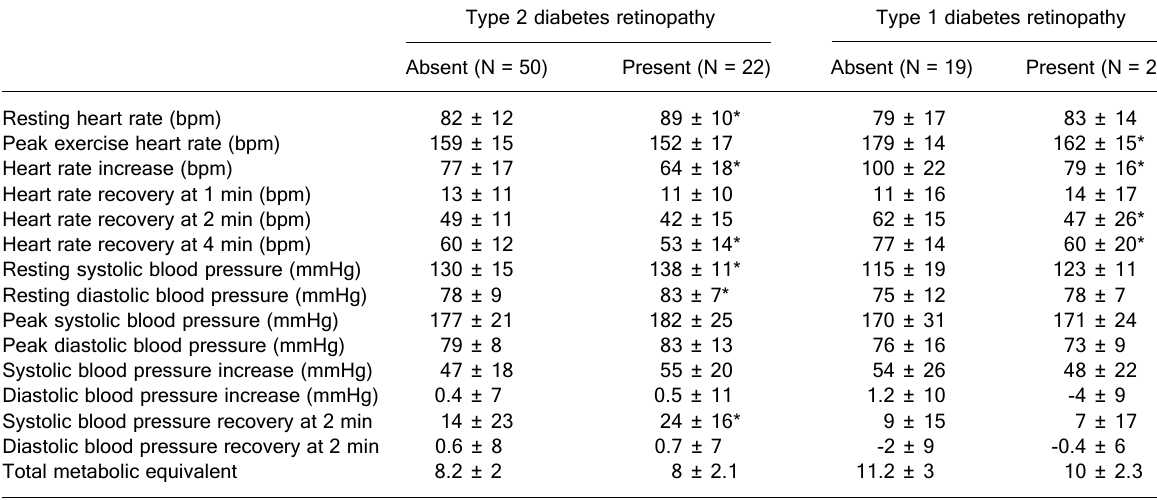
Table 2. Exercise testing variables as a function of the presence of diabetic retinopathy in type 2 and type 1 diabetic